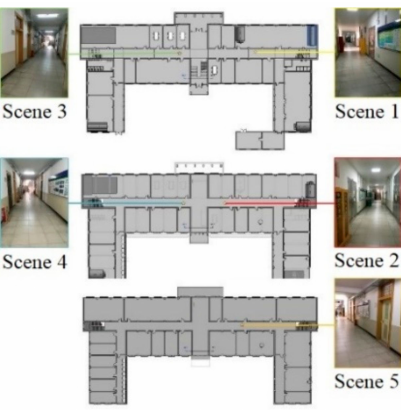
Figure 14. Reference images of different scenes in the building.